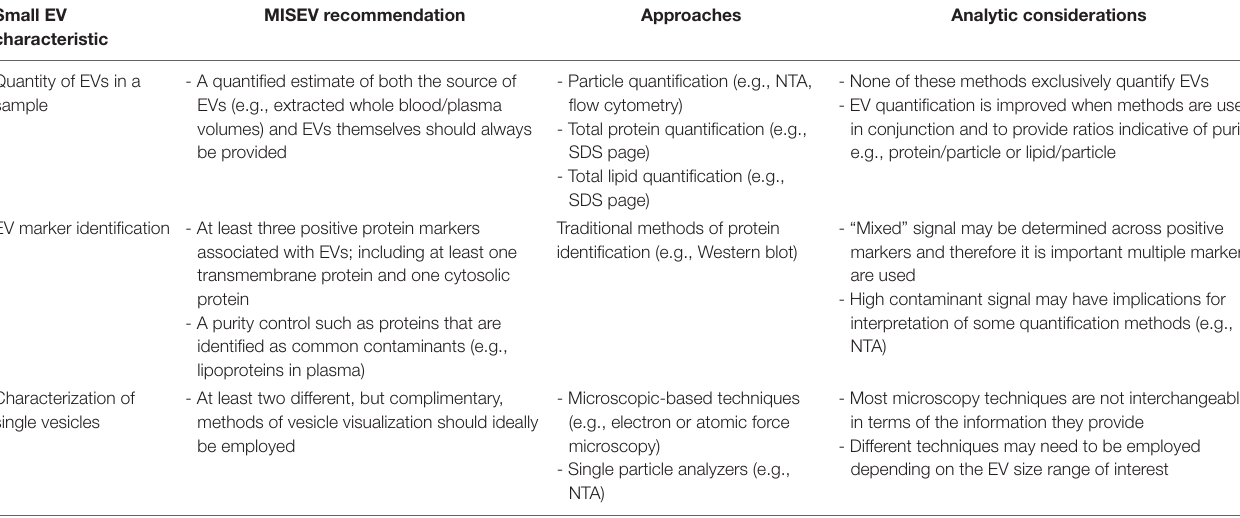
TABLE 1 | Summary of the minimal information for the study of extracellular vesicles (MISEV)